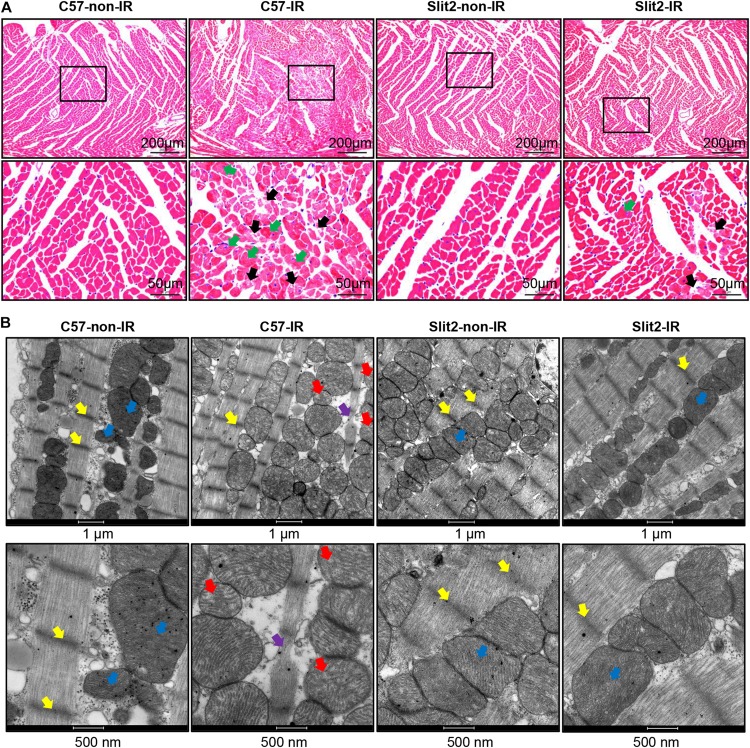
Post-ischemia–reperfusion (IR) injury in C57BL/6J and Slit2-Tg hearts. (A) Representative images of hematoxylin–eosin (HE) staining in C57BL/6J and Slit2-Tg hearts. Scale bar = 200 μm (top) or 50 μm (bottom). The bottom panels show the magnified views of the black framed areas of the corresponding upper panels. The black framed area of the C57-IR heart section displays necrosis. The black arrows indicate ruptured cardiomyocytes; the green arrows indicate swollen cardiomyocytes. (B) Subcellular structures of cardiomyocytes as examined by TEM in C57BL/6J and Slit2-Tg hearts. Scale bar = 1 μm (top) or 500 nm (bottom). C57-non-IR, C57BL/6J hearts not subjected to IR; Slit2-non-IR, Slit2-Tg hearts not subjected to IR; C57-IR, C57BL/6J hearts subjected to IR; Slit2-IR, Slit2-Tg hearts subjected to IR. Arrows: yellow, Z-discs; blue, normal mitochondria; red, post-IR mitochondria with disappearing crista; purple, ruptured Z-discs.